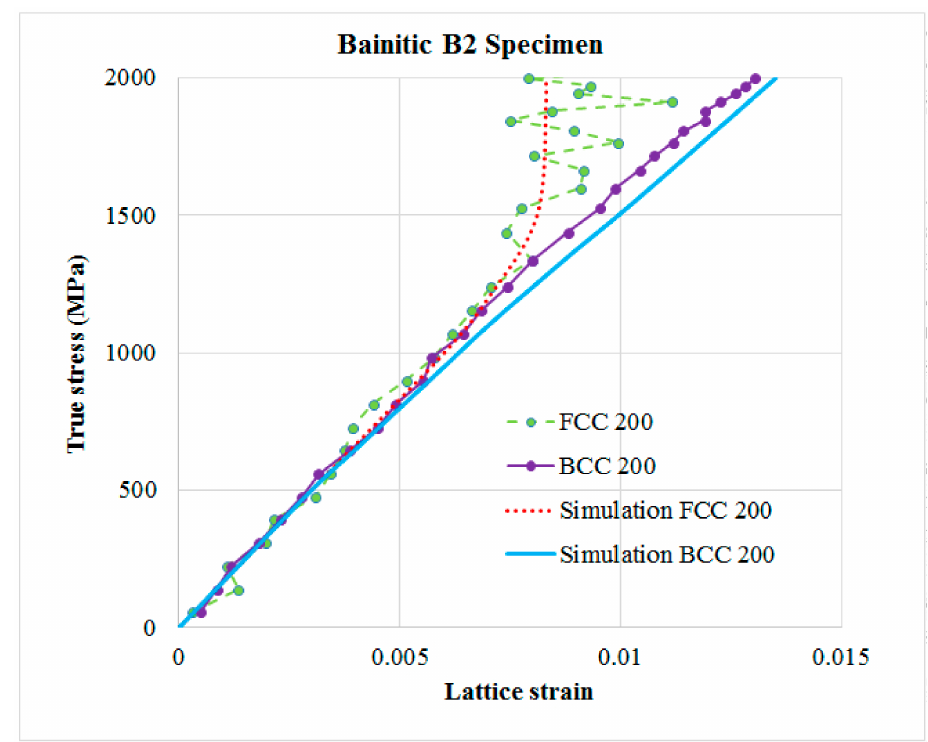
Figure 10. CPFE estimation and experiment results for lattice strains in the bainitic B2